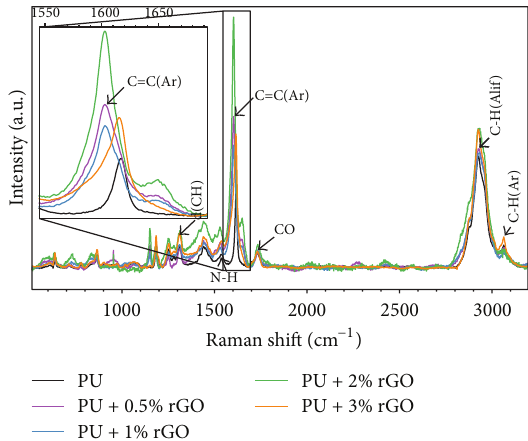
Figure 5: Raman spectra of PU nanocomposites.